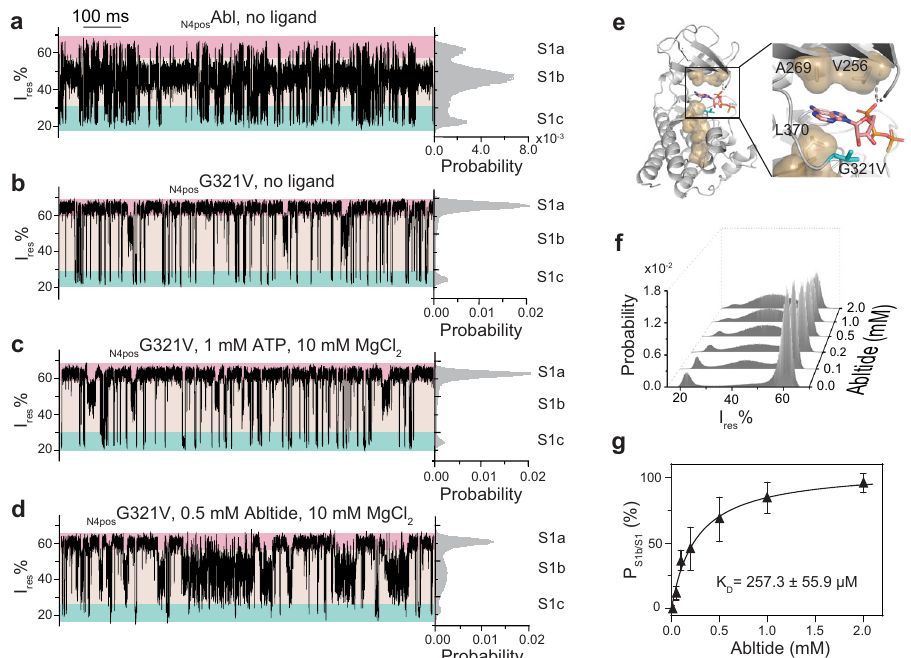
Fig. 5 Trapping of catalytic inactive G321V mutant with ClyA-AS nanopore tweezers. a – d Representative S1 state traces and corresponding histograms of apo N4pos Abl ( a ), apo N4pos G321V ( b ) and N4pos G321V in the presence of 1 mM ATP and 10 mM MgCl 2 ( c ), 0.5 mM Abltide and 10 mM MgCl 2 ( d ). S1 sub-states S1a, S1b, and S1c were highlighted with pink, beige, and cyan, respectively. e Structure of G321V modeled from ATP γ S-bound wildtype Abl kinase structure (PDB ID: 2G2F). ATP γ S is shown as a stick with carbon atoms colored in pink. G321V mutation is shown as a stick and colored in cyan. Hydrophobic residues forming the C-spine are shown in the surface model and highlighted in sand color, V256, A269, and L370 are close to the ATP/ ATP γ S binding site. f Histogram of S1 state for Abltide titration to N4pos G321V. g Determination of the binding af fi nity of Abltide to N4pos G321V based on the S1 state histograms. Data were represented as mean ± SD, n = 3 independent replicates. Source data are provided as a Source Data fi le. The current traces were collected at − 80 mV in buffer 150 mM NaCl, 100 mM Tris-HCl, pH 7.5, at 22